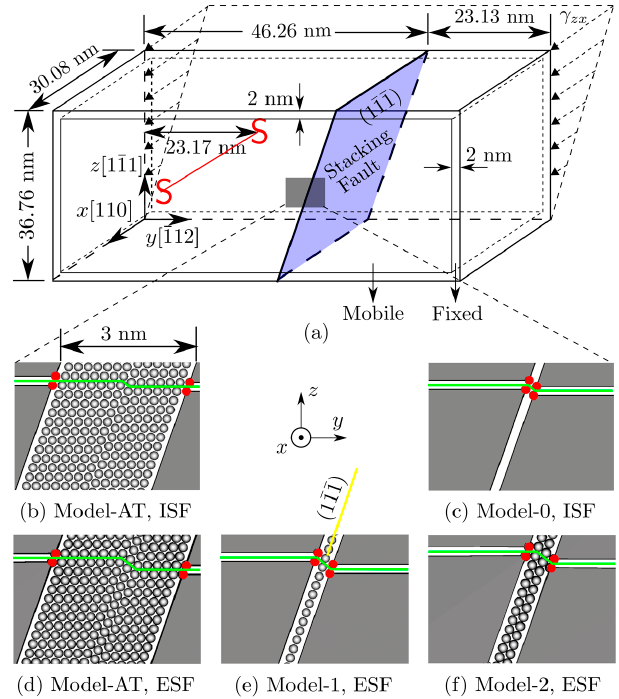
Figure 3. ( a ) An illustration of the simulation cell for interactions between a screw dislocation and an SF. An ISF is described using Model-AT and Model-0, as shown in ( b , c ), respectively. An ESF is described using Model-AT, Model-1, and Model-2, as shown in ( d – f ), respectively. The red and gray circles are nodes and atoms, respectively. The gray shades are rhombohedral elements. The green line is the dislocation migration pathway if the dislocation is transmitted across the SF. By shifting two adjacent (11(cid:3364)1(cid:3364)) atomic planes against each other by ((cid:1853) (cid:2868) /6)(cid:4670)1(cid:3364)12(cid:3364)(cid:4671) , an ISF is